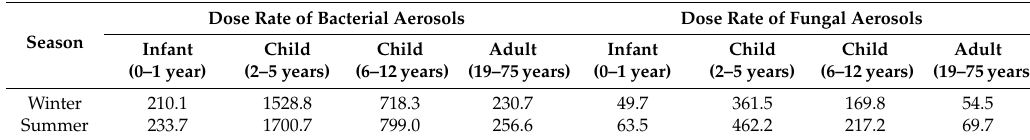
Table 2. Age-specific dose rates (CFU/kg/day) of bioaerosols in PM